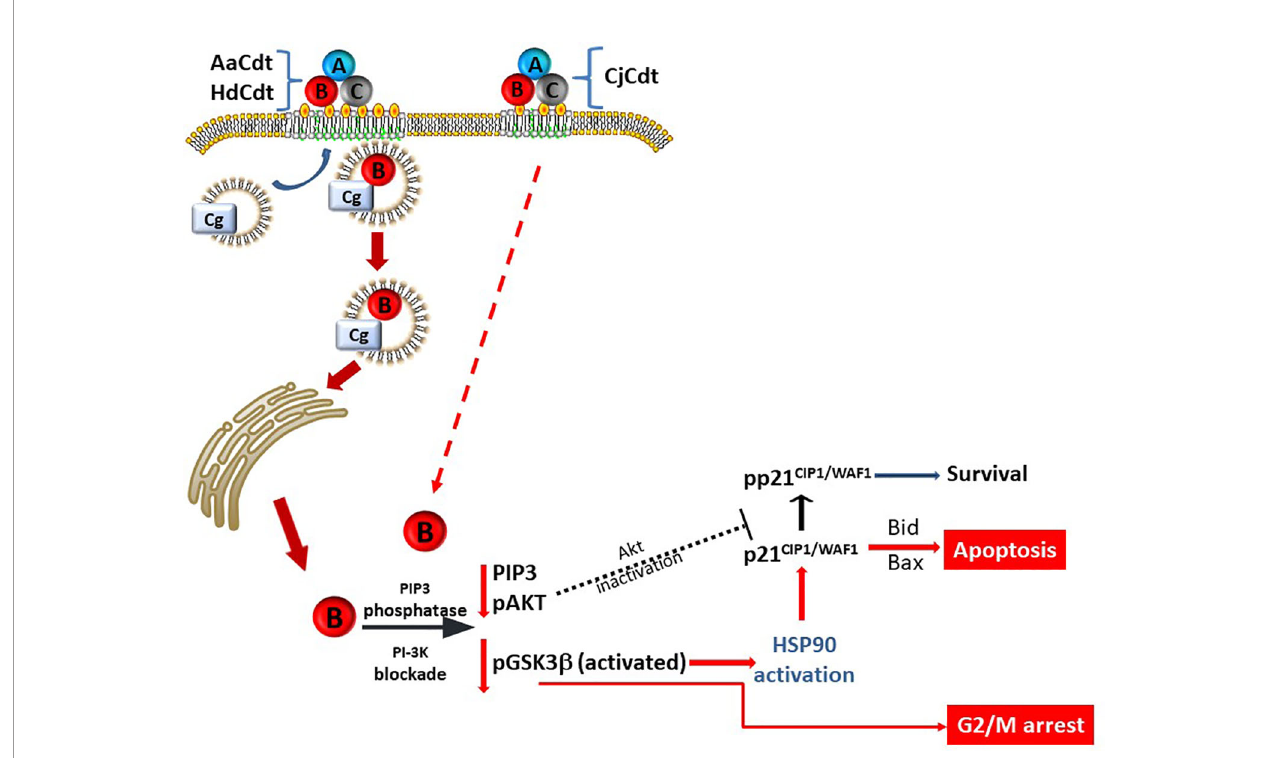
FIGURE 7 | Schematic model showing proposed mechanism for CdtB internalization and toxicity in human lymphocytes. AaCdt, HdCdt, and CjCdt bind to cells via cholesterol in the context of membrane lipid rafts. As a result of exposure to Cdt, cellugyrin-containing SLMVs translocate from cytosol to membrane lipid rafts. We propose that this translocation leads to the association of AaCdtB and HdCdtB with the cellugyrin-containing SLMVs. This interaction may involve direct binding to cellugyrin either on extra- or intra-vesicular loops or indirect association via an un-identi fi ed binding partner. We further propose that CdtB is transported via SLMVs to intracellular target sites, such as locations containing PIP3 pools where the enzymatically active CdtB subunit is released from SLMVs and is then able to dephosphorylate the signaling lipid, resulting in PI-3K blockade and toxicity. Based upon CjCdt toxicity independence of cellugyrin for toxicity (and presumably internalization and traf fi cking), we propose that CjCdtB enters through a cellugyrin- independent mechanism, hijacks retrograde transport mechanisms, and, in lymphocytes, accumulates in sites of PIP3 pools similar to AaCdtB and